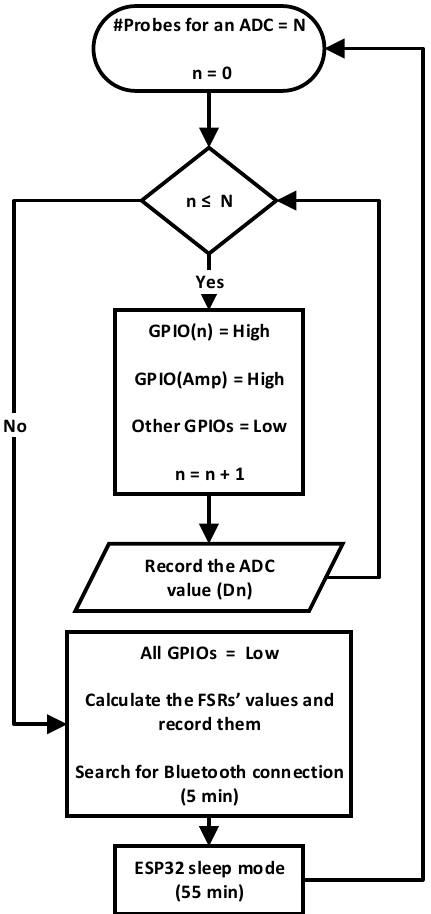
Figure 3. Flowchart of the measurement process in the proposed design.